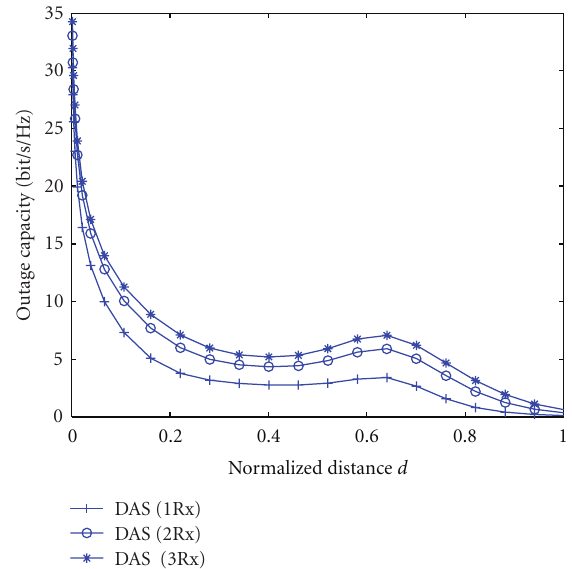
Figure 4: Outage capacity versus the normalized distance from the home